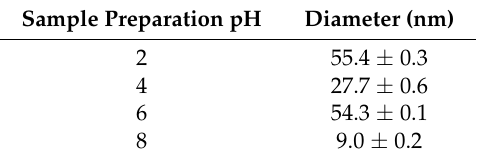
Table 1. Diameter measurements of the Ag-NPs prepared at different pH obtained from TEM micrographs.